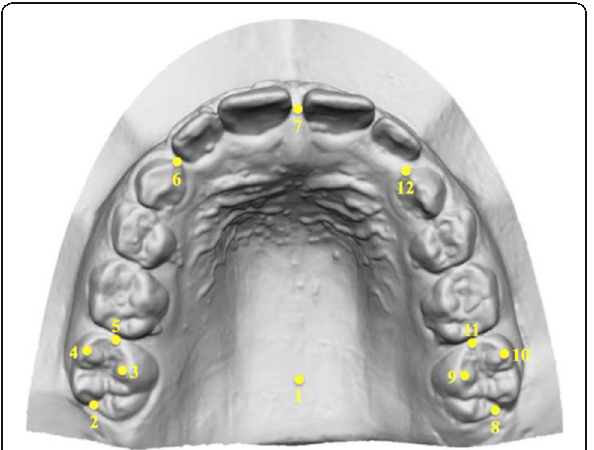
Fig. 3 Example of 12 standardised dental landmarks: 1: the deepest point of the palatal vault; 7: contact point between the central incisors; 2, 8: distal ends of the right and left first molars; 3, 9: mesio-palatal cusp tips of the first molars; 4, 10: mesio-buccal cusp tips of the first molars; 5, 11: mesial ends of the right and left first molars; 6, 12: mesial contact points of the right and left primary